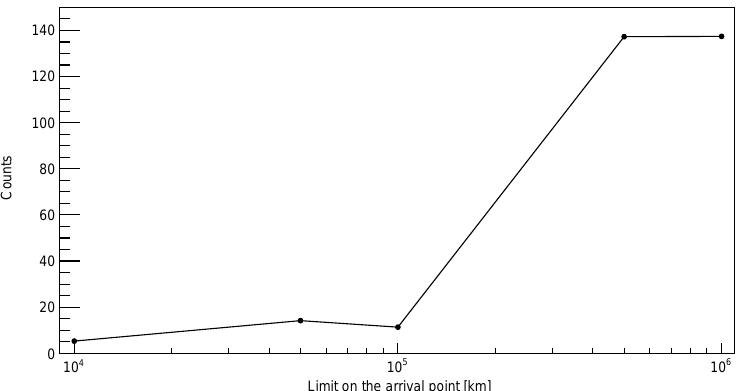
Figure 7. The calculated number of simulations giving observable effects in all executed simulations (10 10 ) as a function of the arrival point limit, on the basis of Figures 5 and